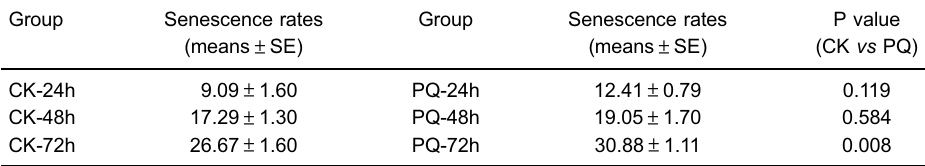
Table 3. Comparison of cell senescence rates of the control (CK) and paraquat (PQ) groups.